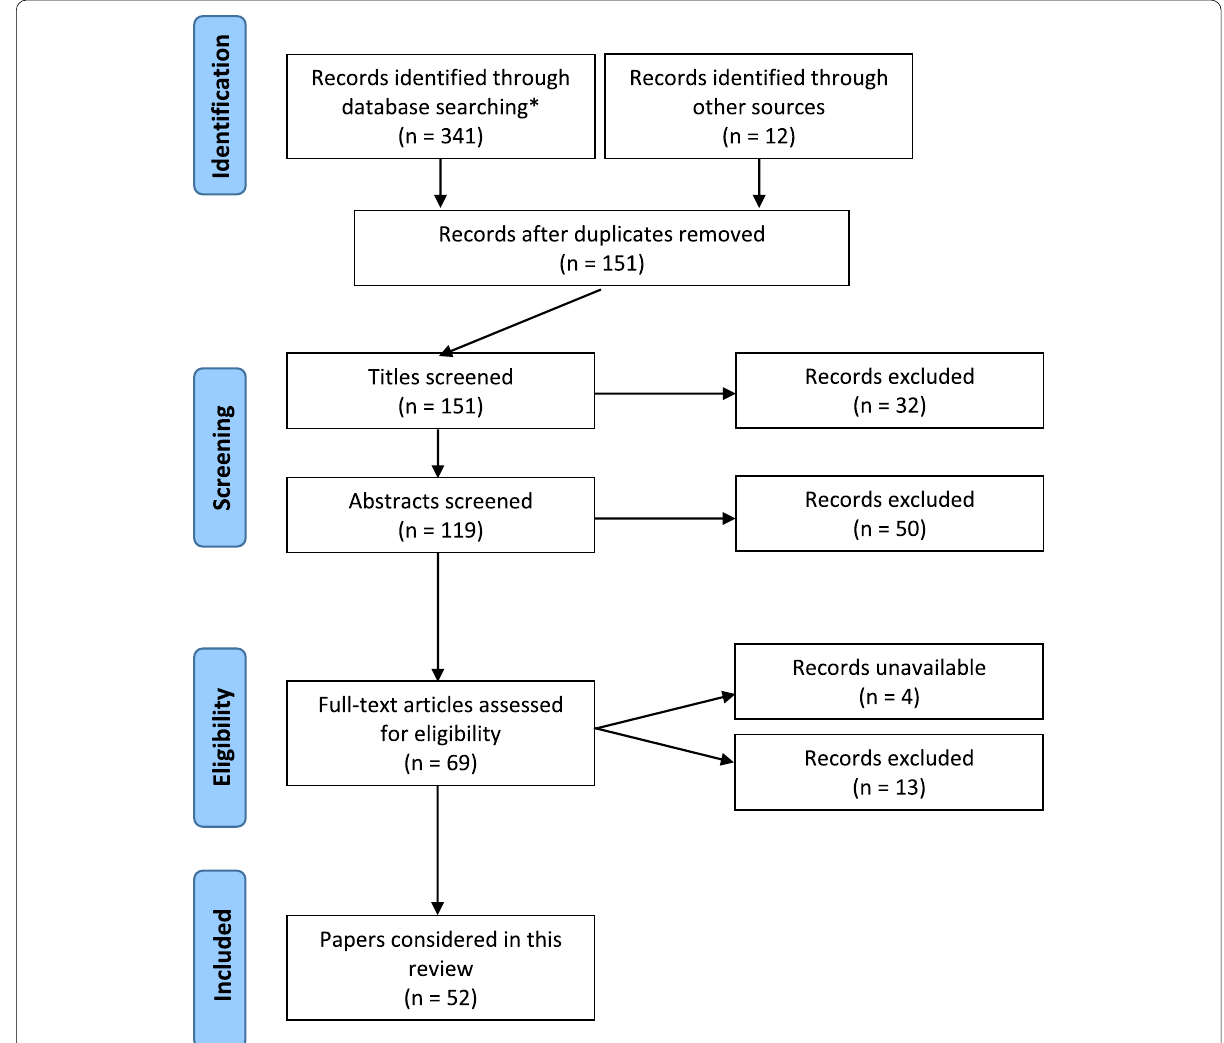
Fig. 1 PRISMA search summary. * Tues Aug 31 03:05:102021 Search: ((artificial intelligence OR AI) AND (orthopaedics OR orthopedics) AND (arthroplasty OR joint replacement) AND (TKR OR THR OR THA OR TKA) AND